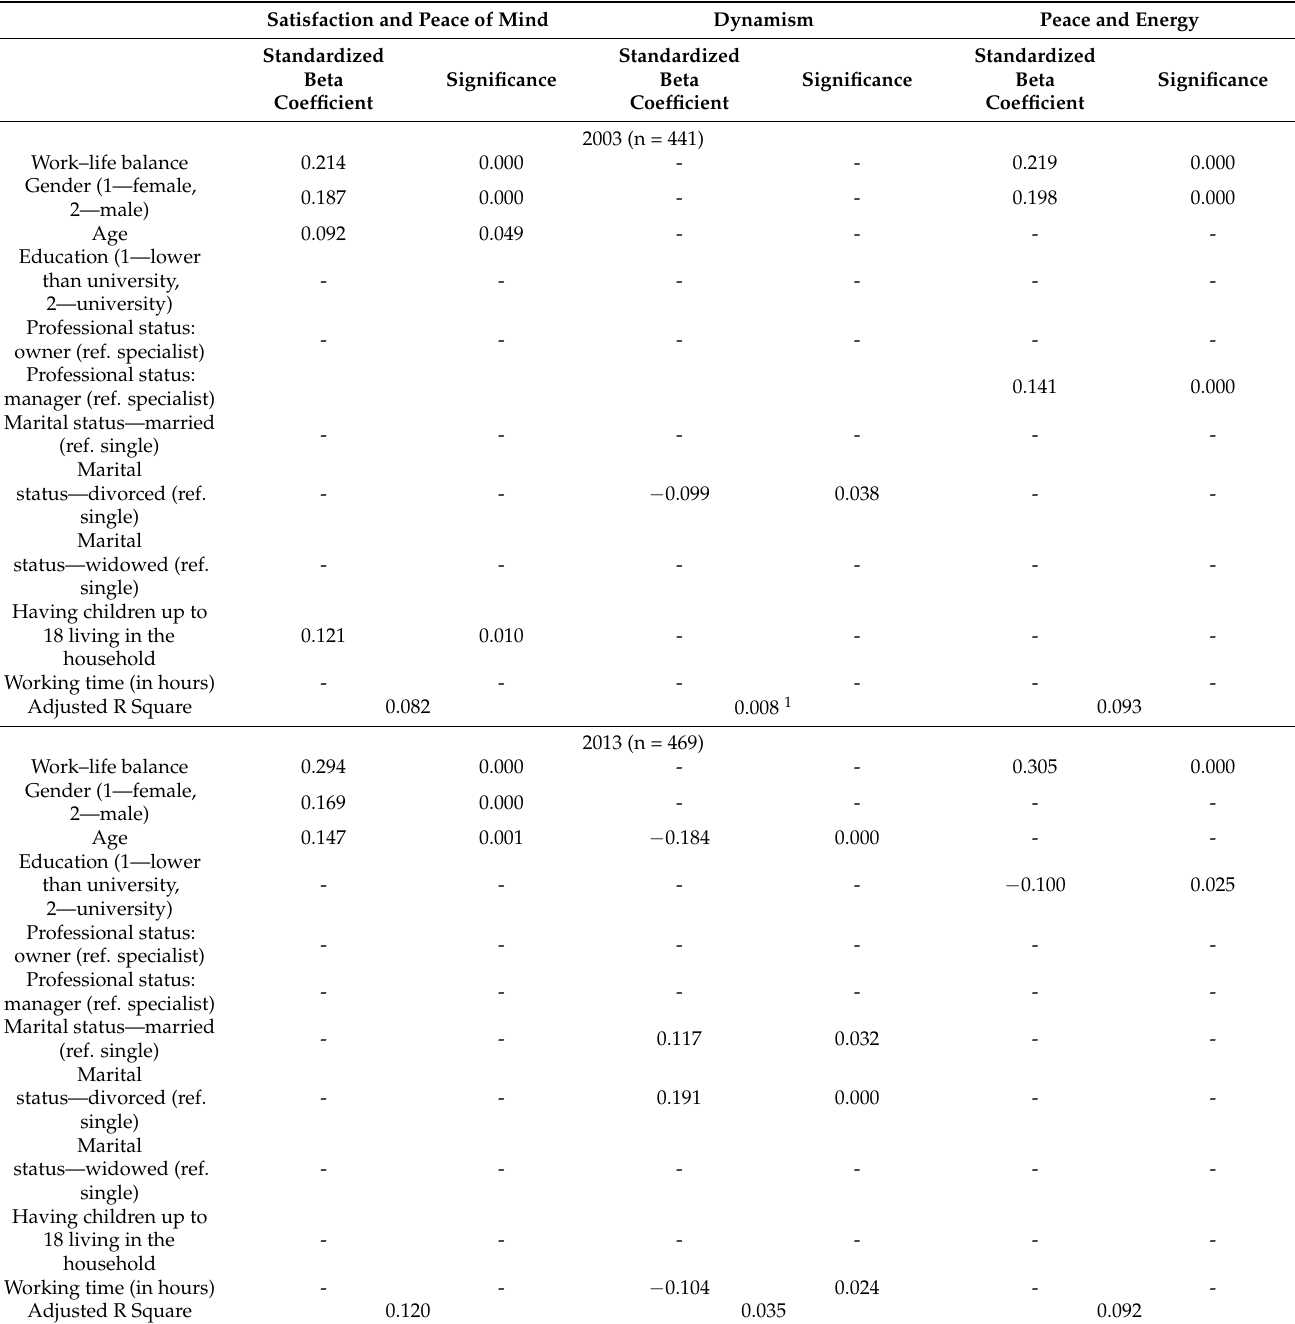
Table 3. Relationship between work–life balance and the dimension of occupational stress: (mental health) controlled by socio-demographic variables. Results of multiple linear regression